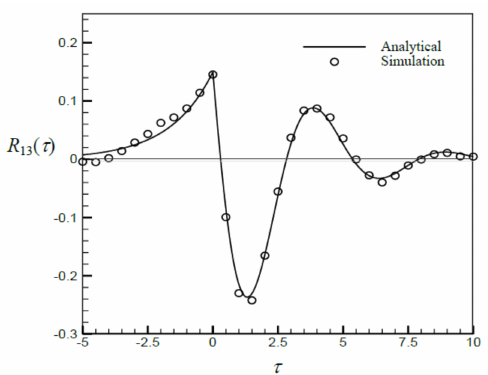
Figure 2. Cross − correlation function R 13 ( τ ) of X 1 ( t ) and X 3 ( t ) for Equation (9) using the linear filter